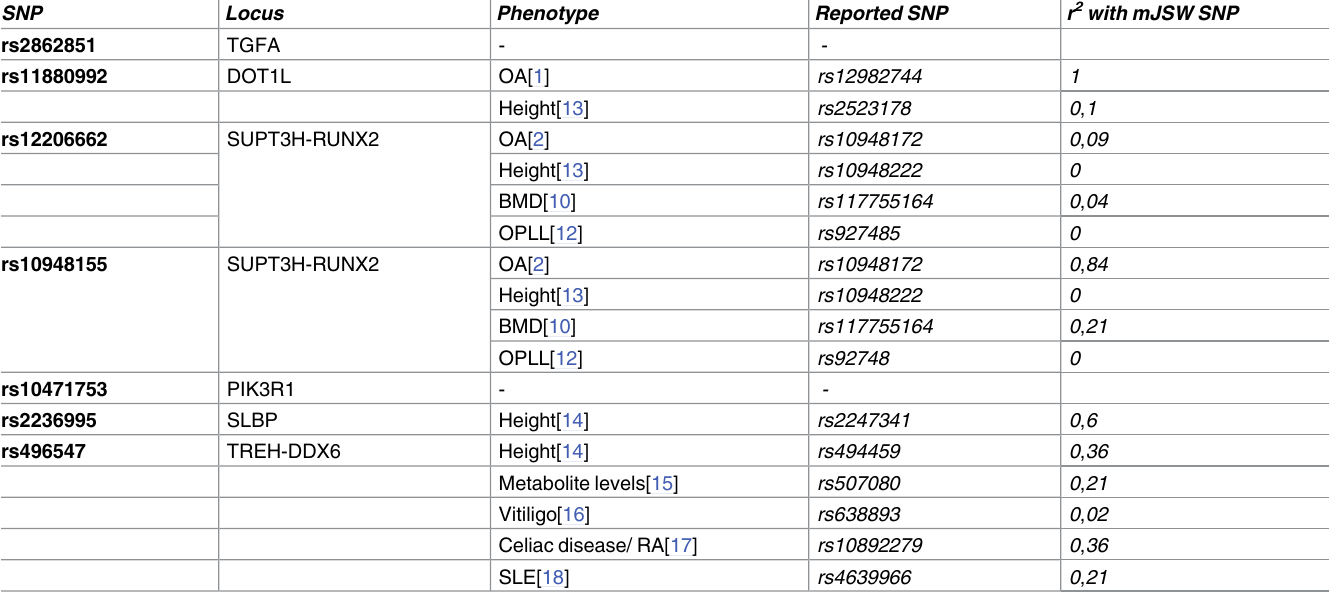
cartilage samples of the RAAK study acquired from 33 donors at the time of joint replacement surgery for primary OA [19]. We first examined which genes are expressed in a set of seven human healthy cartilage samples (S7 Table). Additionally, we tested which of the genes located in 1MB region surrounding the lead SNP were differentially expressed in OA-lesioned cartilage versus non-lesioned cartilage of the same hip. Of the 152 genes that were selected, 129 genes were represented on the array. Of those, 64 genes were significantly expressed in the cartilage samples. For eight of the twelve loci, we found genes that were differentially expressed in OA lesioned cartilage versus non-lesioned cartilage (Table 4, S10 Table). Differential expression in cartilage healthy vs OA affected cartilage was performed likewise(S10 Table), while additionally adjusting for sex and age. Given the relatively small number of healthy samples (n = 7) with large age range these data are less robust and we did not use these data in gene prioritization. For each gene a prioritization score was computed, based on equally weighting of the ten lines of evidence (Table 4). Following this approach, RUNX2 is highly likely to be the causal gene associated with rs12206662 and rs10948155. Similar strong evidence is found for rs788748 (IGFBP3) and rs10492367 ( PTHLH) . In addition, suggestive evidence for a causal gene is found